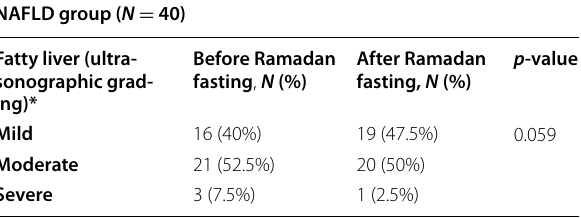
Table 3 Comparison of the ultrasonographic grading of fatty liver between before and after Ramadan fasting in the study